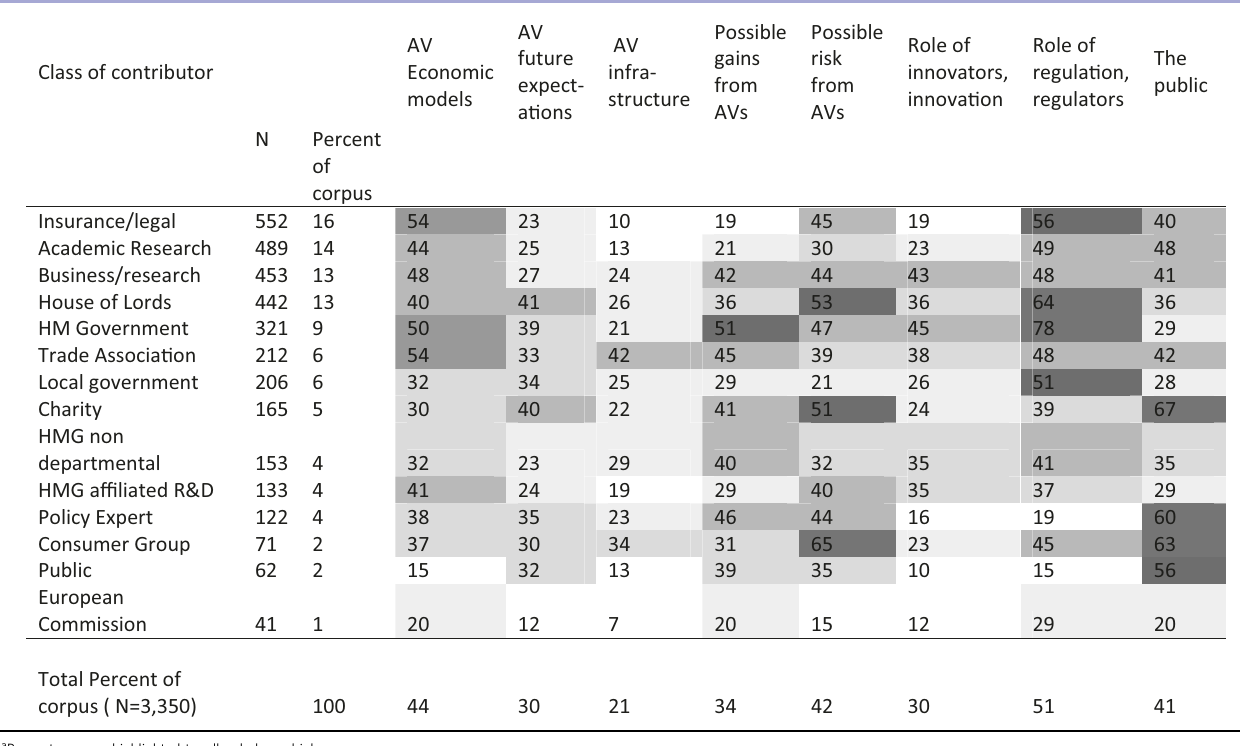
Table 3 Distribution of major themes (head codes) within categories of contributors.